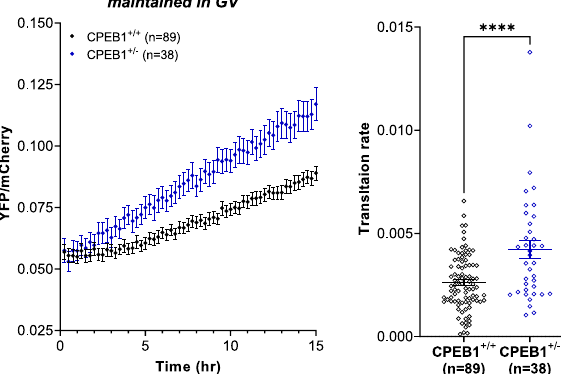
Fig. 5| Decreased CPEB1expressionde-repressesCcnb1 translationduringthe GV stage. a – d, g – j GV oocytes from young and old mice ( a – d ) or Cpeb1 +/+ ;Zp3Cre mice (CPEB1 +/+ oocytes) and Cpeb1 fl /+ ;Zp3Cre mice (CPEB1 +/ − oocytes) ( g – j ) were injected with polyadenylated mCherry and YFP-Ccnb1 3 ’ -UTR ( a , b , g , h ) or YFP- Ccnb2 3- ’ UTR( c , d , i , j ).After3hof pre-incubation,oocytesweremaintainedinGV stagewithcilostamidetreatment.YFPandmCherrysignalswererecordedbytime- lapse microscopy every 15min for 15h. The YFP signals were normalized by the level of mCherry signals. a , c , g , i YFP/mCherry signal in each oocyte was plotted dependingontheincubationtime. b , d , h , j Translationratewascalculatedforeach oocyte by linear regression of the reporter data between 3 and 13h.